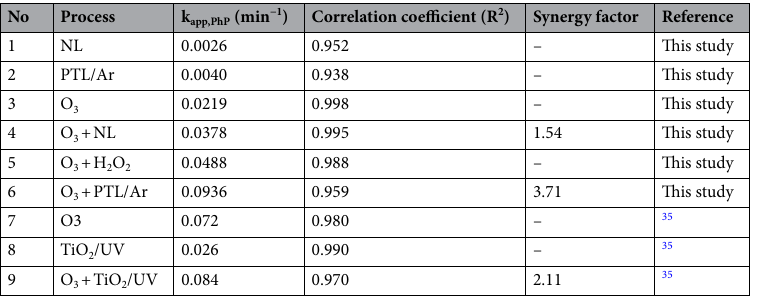
Table 3. The apparent pseudo-first-order rate constants, corresponding linear regression coefficients and synergy factor of decay PhP by various processes on.